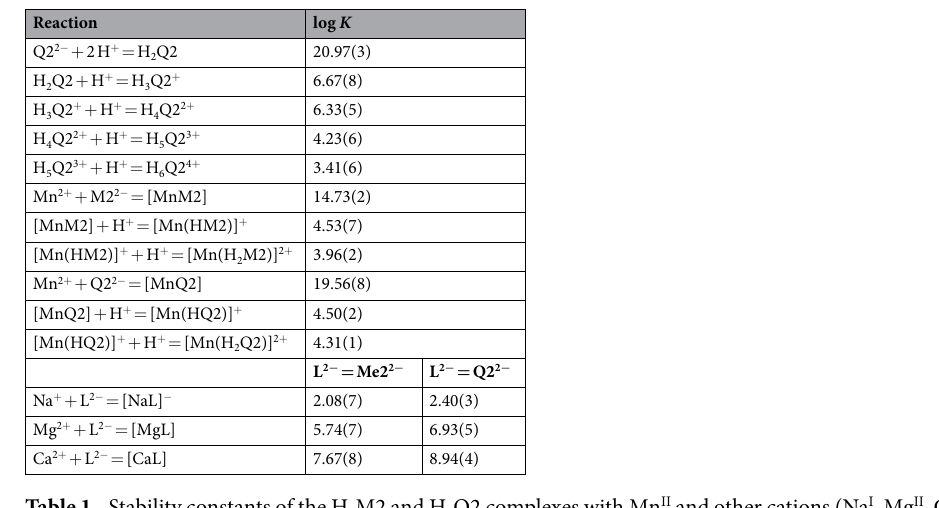
Table 1. Stability constants of the H 2 M2 and H 2 Q2 complexes with Mn II and other cations (Na I , Mg II , Ca II )